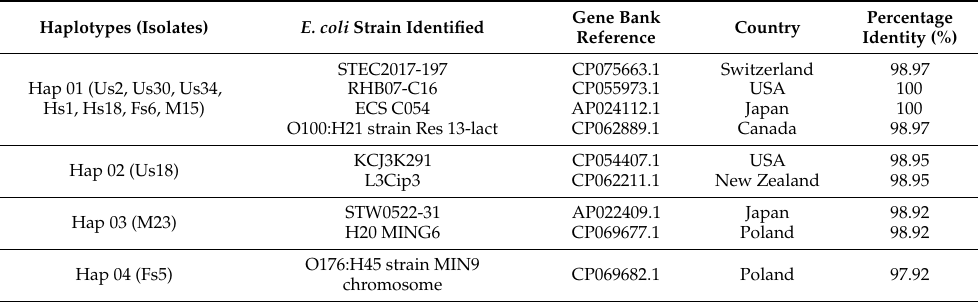
Table 4. Nucleotide identity of E. coli isolates in the present study compared with reference gene in the